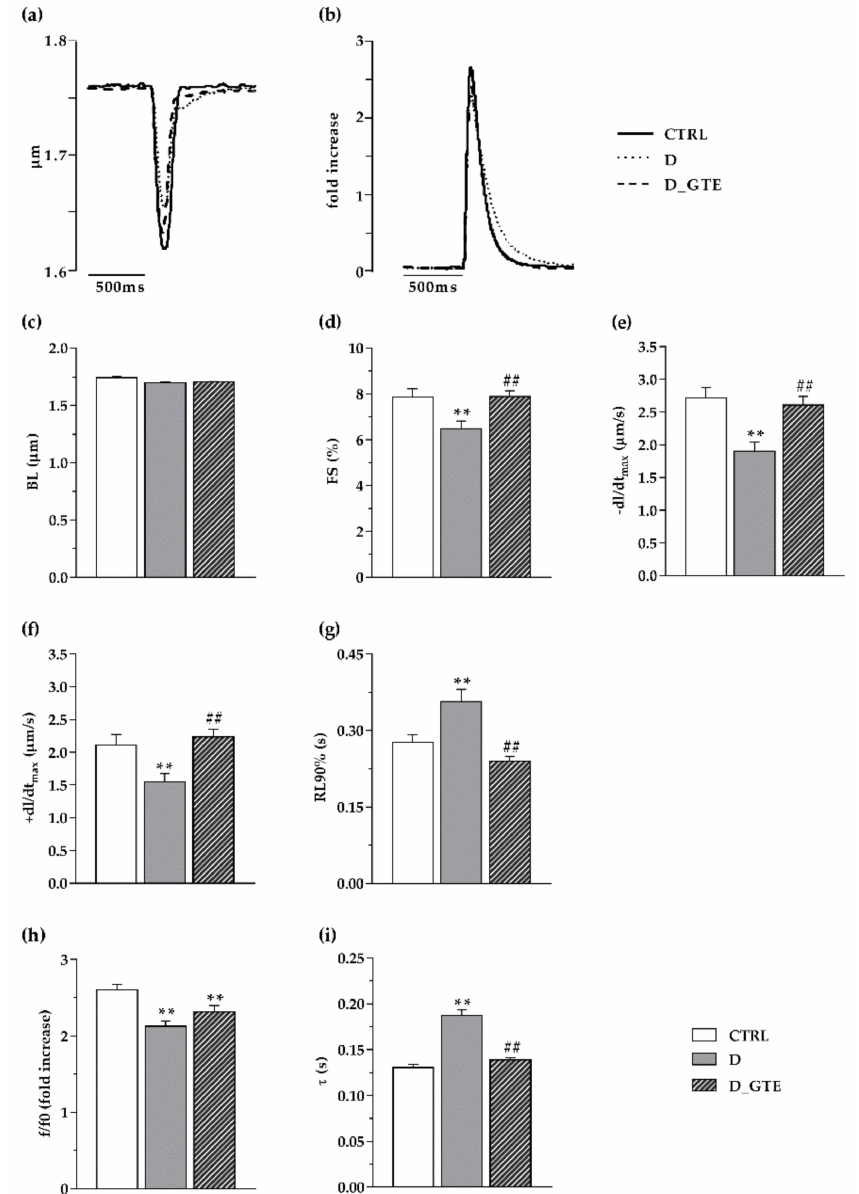
Figure 1. Cell mechanics and calcium transients. Representative examples of ( a ) sarcomere shortening and ( b ) corresponding calcium transients (normalized traces: fold increase) recorded from CTRL (solid line), D (dotted line) and D_GTE (dashed line) ventricular myocytes. In the c–i bar graphs, the mean values ± SEM of ( c ) mean diastolic sarcomere length (BL), ( d ) sarcomere fraction of shortening (FS), ( e ) maximal rate of shortening ( − dL/dt max ), ( f ) maximal rate of relengthening (+dL/dt max ), ( g ) time to 90% of relengthening (RL90%), ( h ) calcium transient amplitude, expressed as peak fluorescence, normalized to baseline fluorescence (f/f0), and ( i ) time constant of the intracellular calcium decay ( τ ), measured in CTRL (59 cells), D (56 cells) and D_GTE (55 cells). ** p < 0.01 significant differences vs. CTRL; ## p < 0.01 significant differences vs. D (GLM ANOVA for repeated